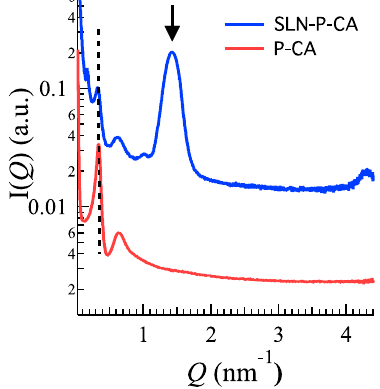
Figure 7. X-ray scattering profiles for P-CA (red) and SLN-P-CA (light blue) samples measured at 37 °C. The dashed line indicates the position of the gel first correlation peak; the arrow points the position of the first Bragg peak related to the inner organization of the SLN. Experiments were performed at Diamond Light Source (UK).